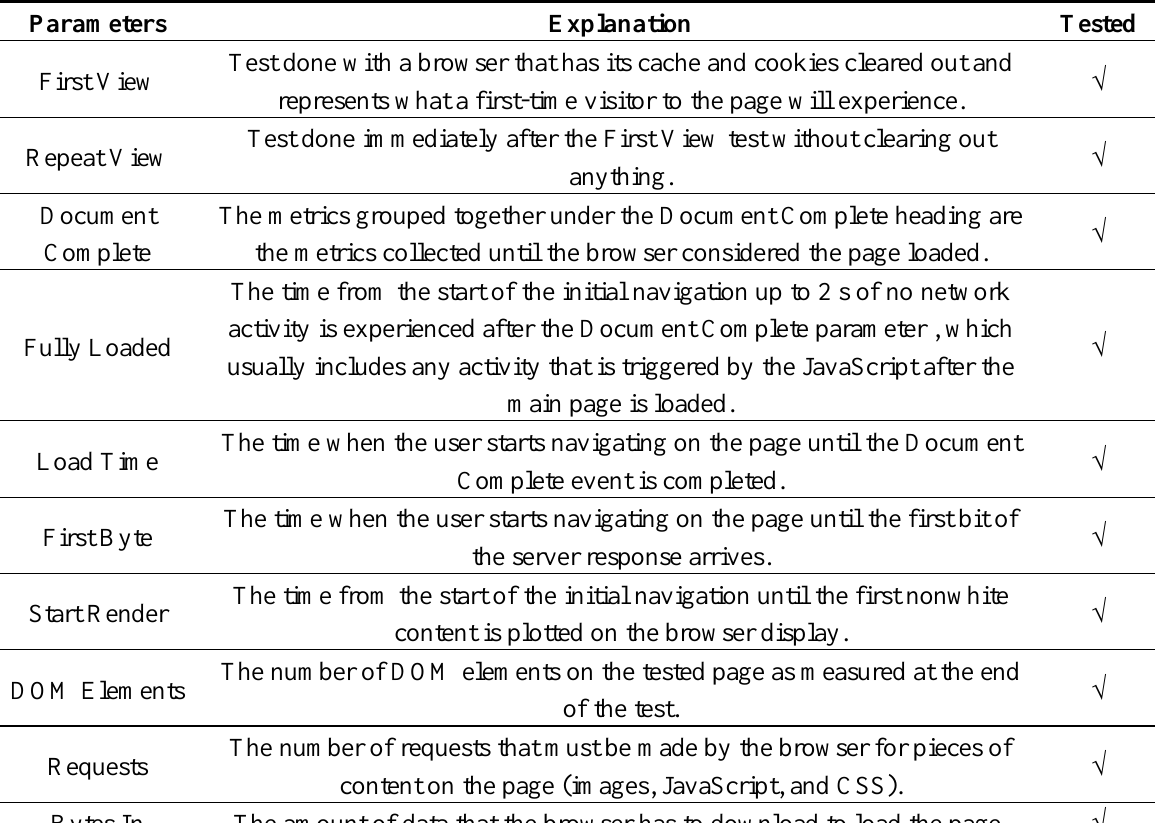
Table 3. Performance evaluation